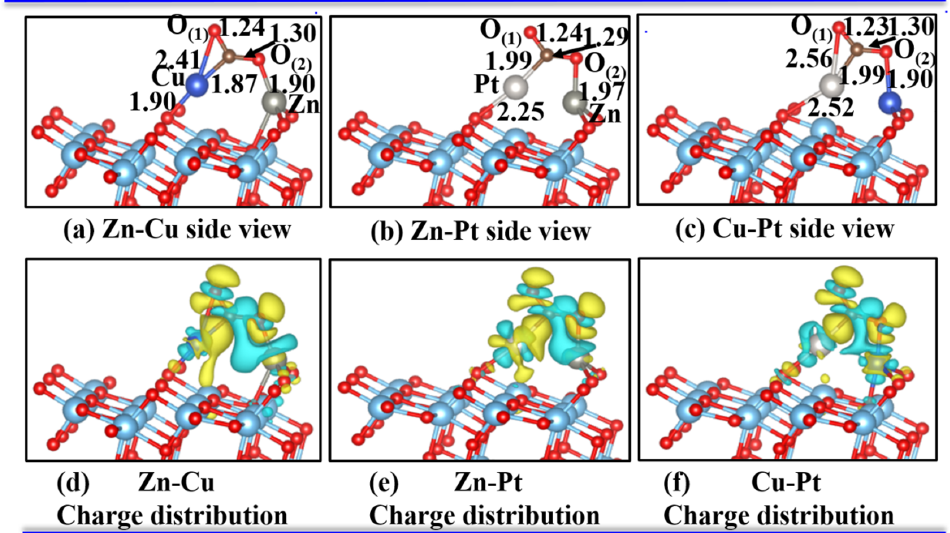
Figure 4. Most stable configurations ( a – c ) and the corresponding charge-density differences ( d – f ) of a CO 2 molecule absorbed on the Zn-Cu, Zn-Pt, and Cu-Pt dimer-embedded A-TiO 2 (101) surface from a side view. The isosurface value was set as 0.0025 e/bohr 3 . The electron accumulation is denoted with the yellow regions, while the electron depletion is denoted with green regions. The Cu atom in dark blue color, Pt atom is pale, and Zn atom in light gray.